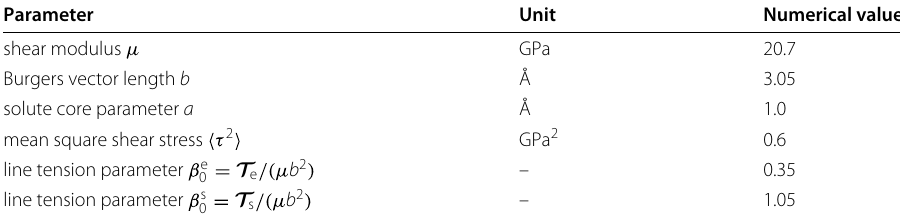
Table 1 Parameters used in numerical calculations Parameter Unit